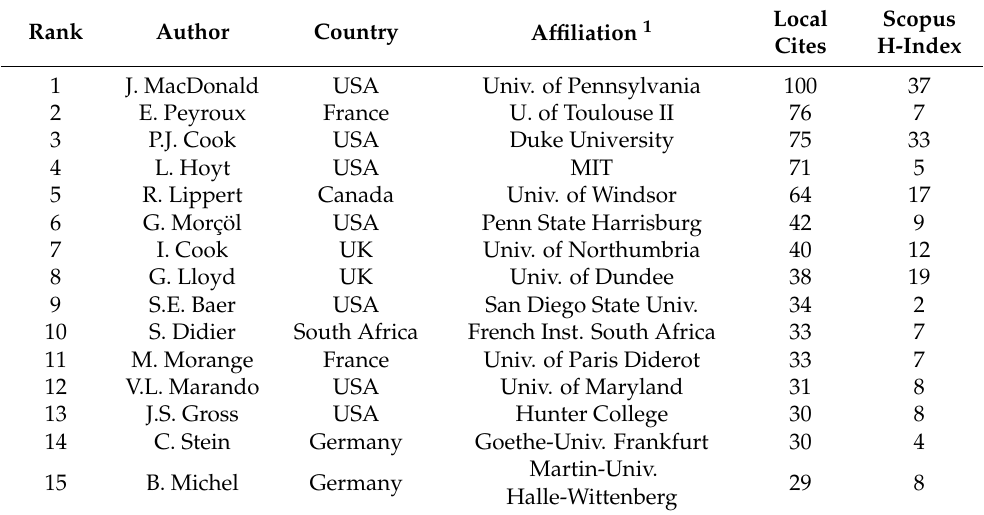
Table 3. Most co-cited authors publishing on BIDs,